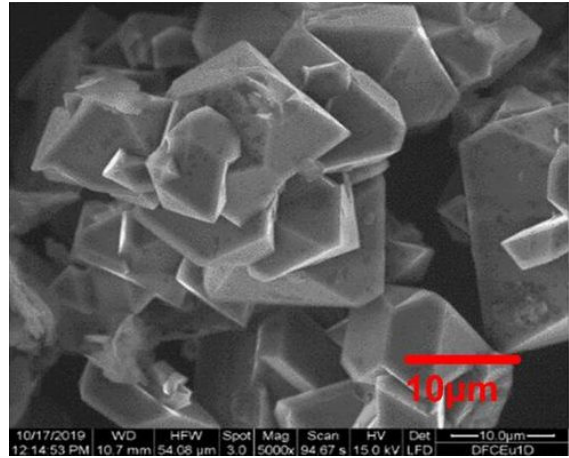
Figure 9. SEM image of purified diamond powder SEu3. Micrometer sized diamond crystals with sharp borders and plane facets are visible.